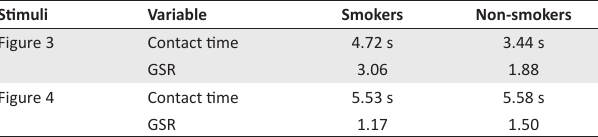
TABLE 10: Mouth and throat cancer warning: Analysis of both text and pictures. Stimuli Variable